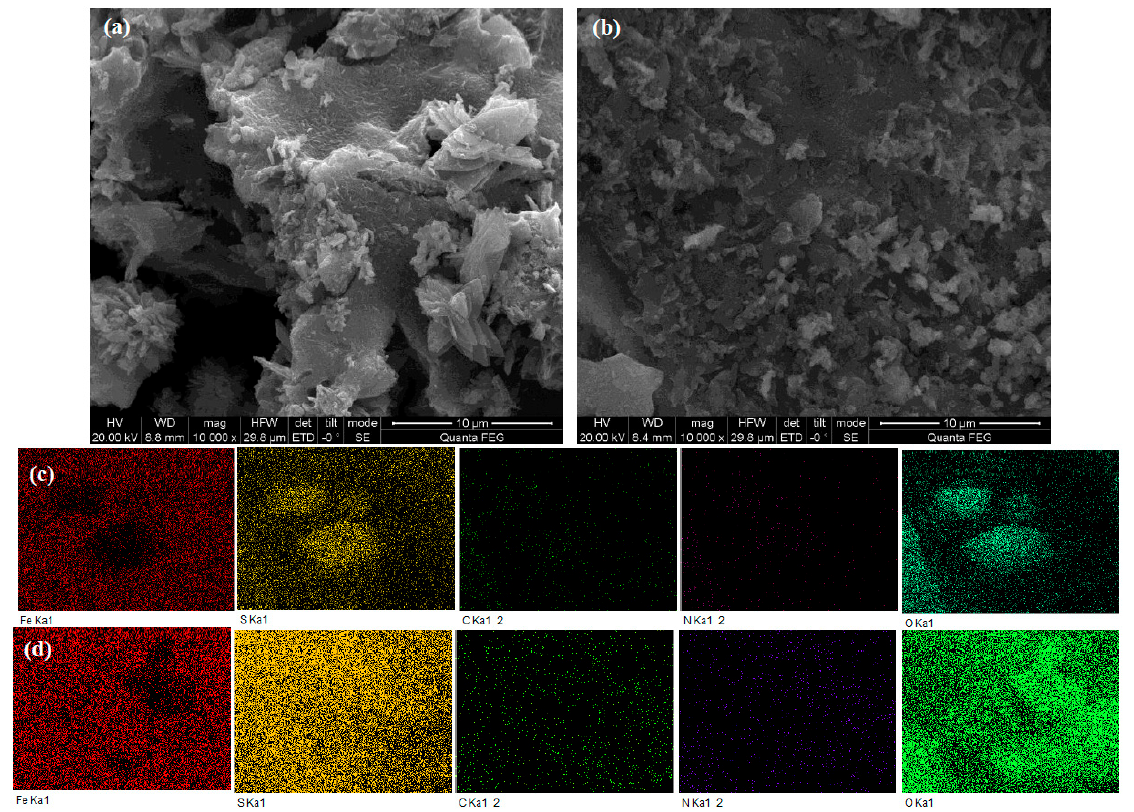
Figure 1. SEM images of RS–FeS ( a ) and RS–EDTA–FeS ( b ). EDS mappings of Fe, S, C, N, and O on RS–FeS ( c ) and RS–EDTA–FeS ( d ).